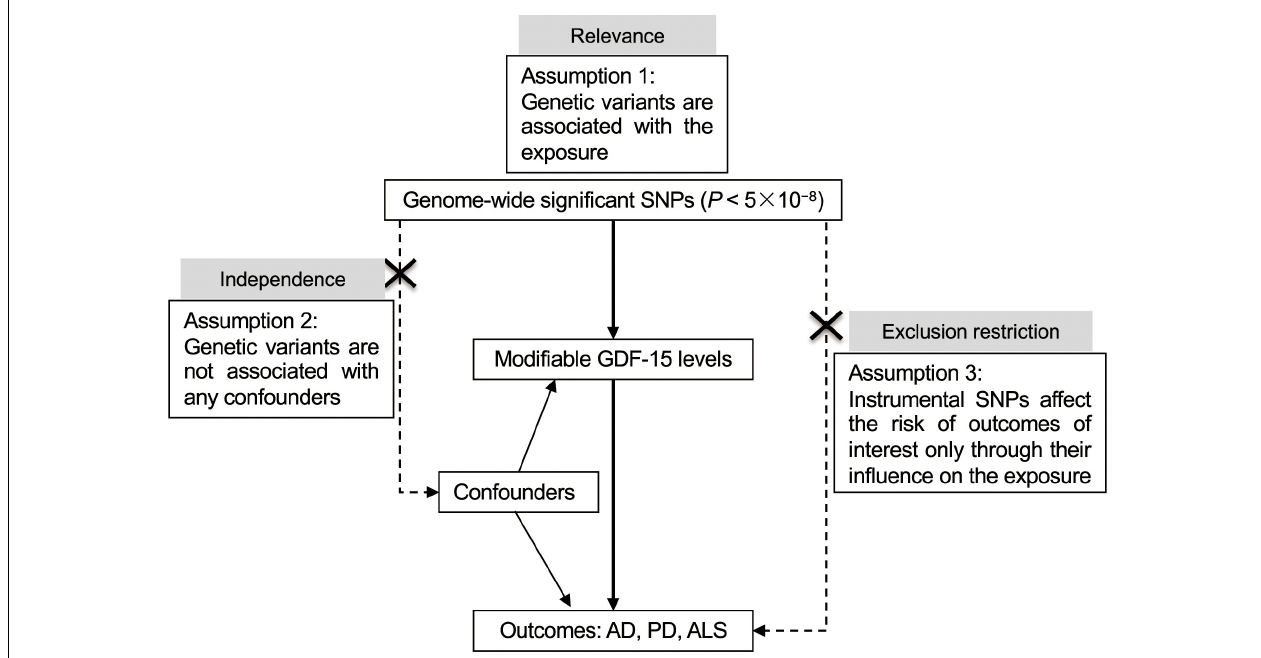
FIGURE 1 | Schematic of the Mendelian randomization study. Three key assumptions underlie the MR study. For illustration, when exploring the causal effect of GDF-15 on AD, genome-wide significant SNPs ( P < 5 × 10 – 8 ) associated with GDF-15 were firstly collected, namely, the relevance assumption. Second, the independence assumption is inherently met given the MR design. Randomized allocation of risk alleles occurs in gamete formation, which far precedes the onset of AD, and is not susceptible to intervening factors in later life as commonly exist in the traditional observational studies. Third, instrumental variables exert their influence on AD only via the GDF-15 pathway, known as the exclusion–restriction assumption. MR sensitivity analyses were performed to examine horizontal pleiotropic effects and validate the robustness of the overall estimate. AD, Alzheimer’s disease; ALS, amyotrophic lateral sclerosis; GDF-15, growth differentiation factor 15; MR, Mendelian randomization; PD, Parkinson’s disease; SNP, single-nucleotide